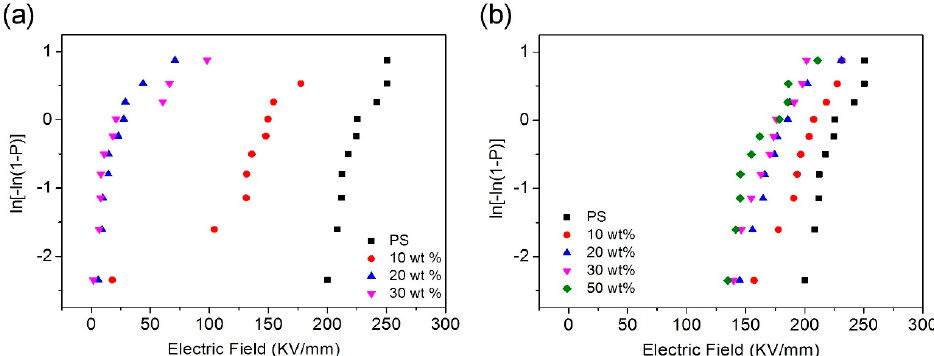
Figure 5. Breakdown strength of Al/PS composite films ( a ) PS film doped with agg -Al NPs and ( b ) PS film doped with iso -Al NPs@PS. film doped with iso -Al